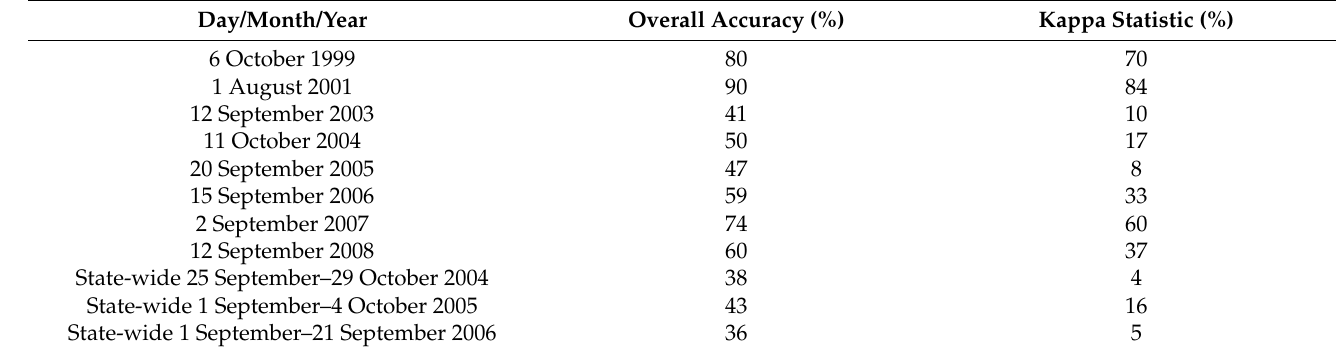
Table 1. Overall accuracy and Kappa statistic for the YPA and state-wide regions by year. State-wide classifications include the earliest and latest image dates for the 11 classified